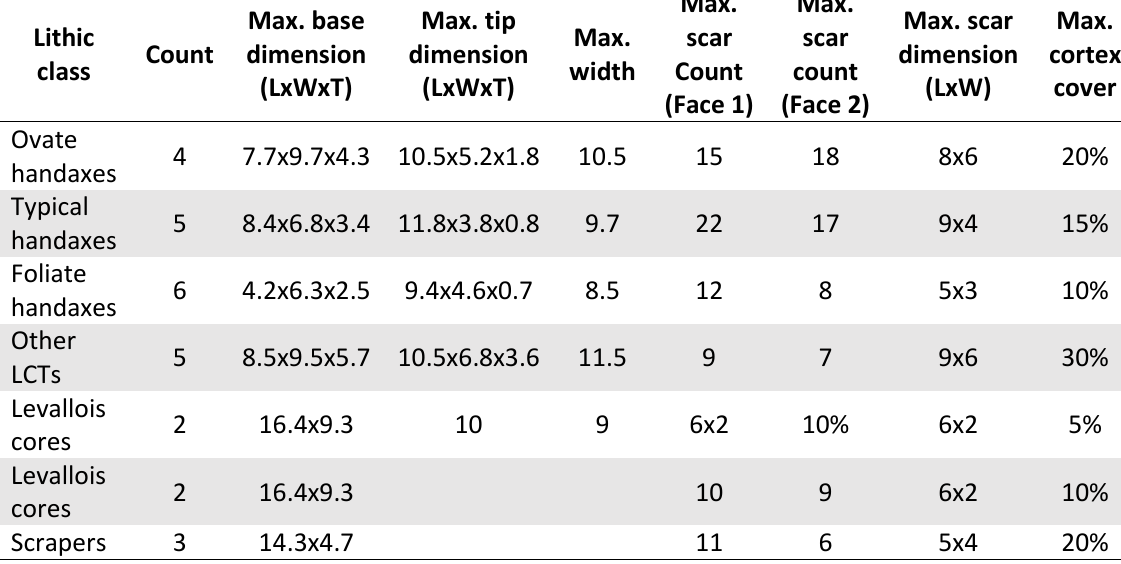
Table 1. Basic metric data of 27 Stone tools measured in the field from the surface of Al-Huwaidy Palaeolithic site and not collected, (L: Length, W: Width, T: Thickness). All dimensional units are in cm. For Levallois cores and scrappers Max. base dimension refer to max.